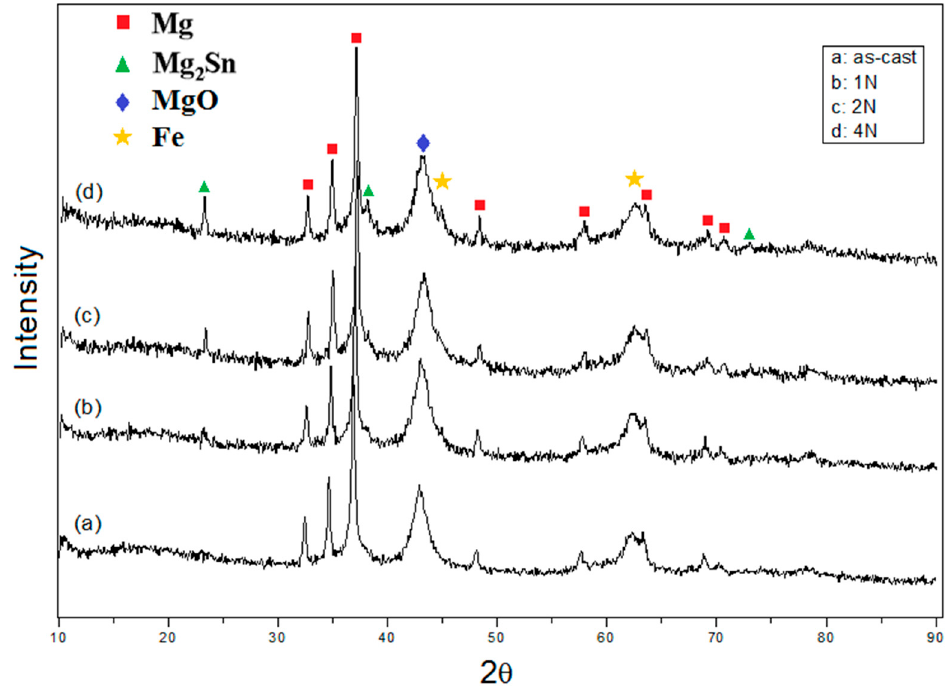
Figure 7. XRD analyses of the wear debris: ( a ) as-cast; ( b ) one-pass (1N); ( c ) two-pass (2N) and ( d ) four-pass (4N).